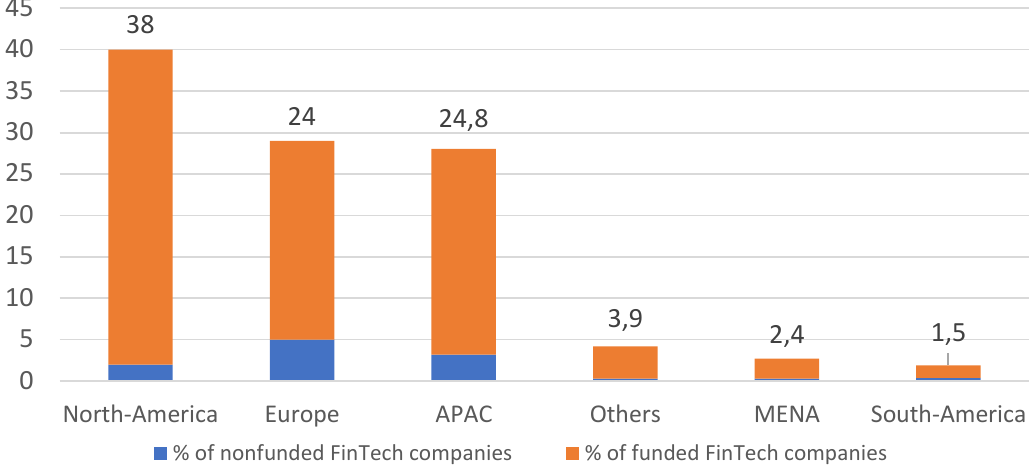
Figure 3. The place of FinTech platforms in the EU countries on the global scale in 2016, %